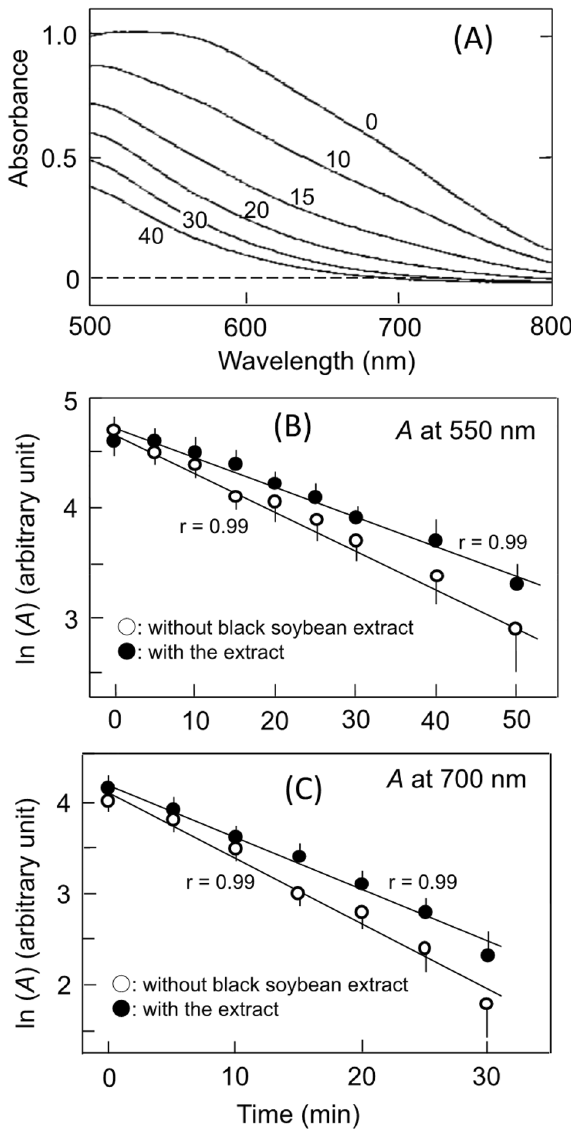
Figure 1. Pancreatin-induced hydrolysis of amylose heated with and without BSB extract. ( A ) Hydrolysis of amylose heated without BSB extract. Numbers on traces; incubation time in min. ( B ) and ( C ) Semi-logarithmic plots of absorbance decrease at 550 and 700 nm, respectively. ( ○ ) Heated without BSB extract, ( ● ) heated with BSB extract. Each data point is mean with standard deviation (n = 3). * p < 0.05. The straight lines were estimated using a least squares